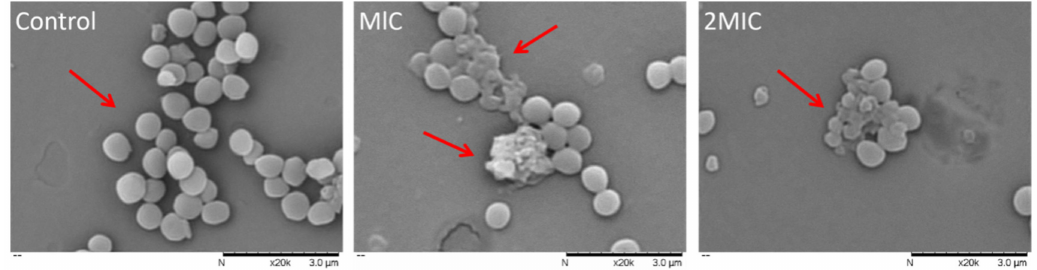
Figure 1. Scanning electron micrographs of S. aureus (untreated, treated with MEO at MIC and 2MIC,